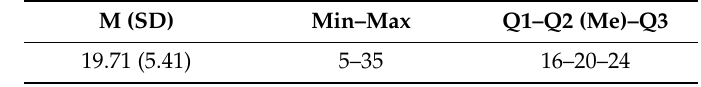
Table 2. Satisfaction With Life Scale (SWLS) scores of the